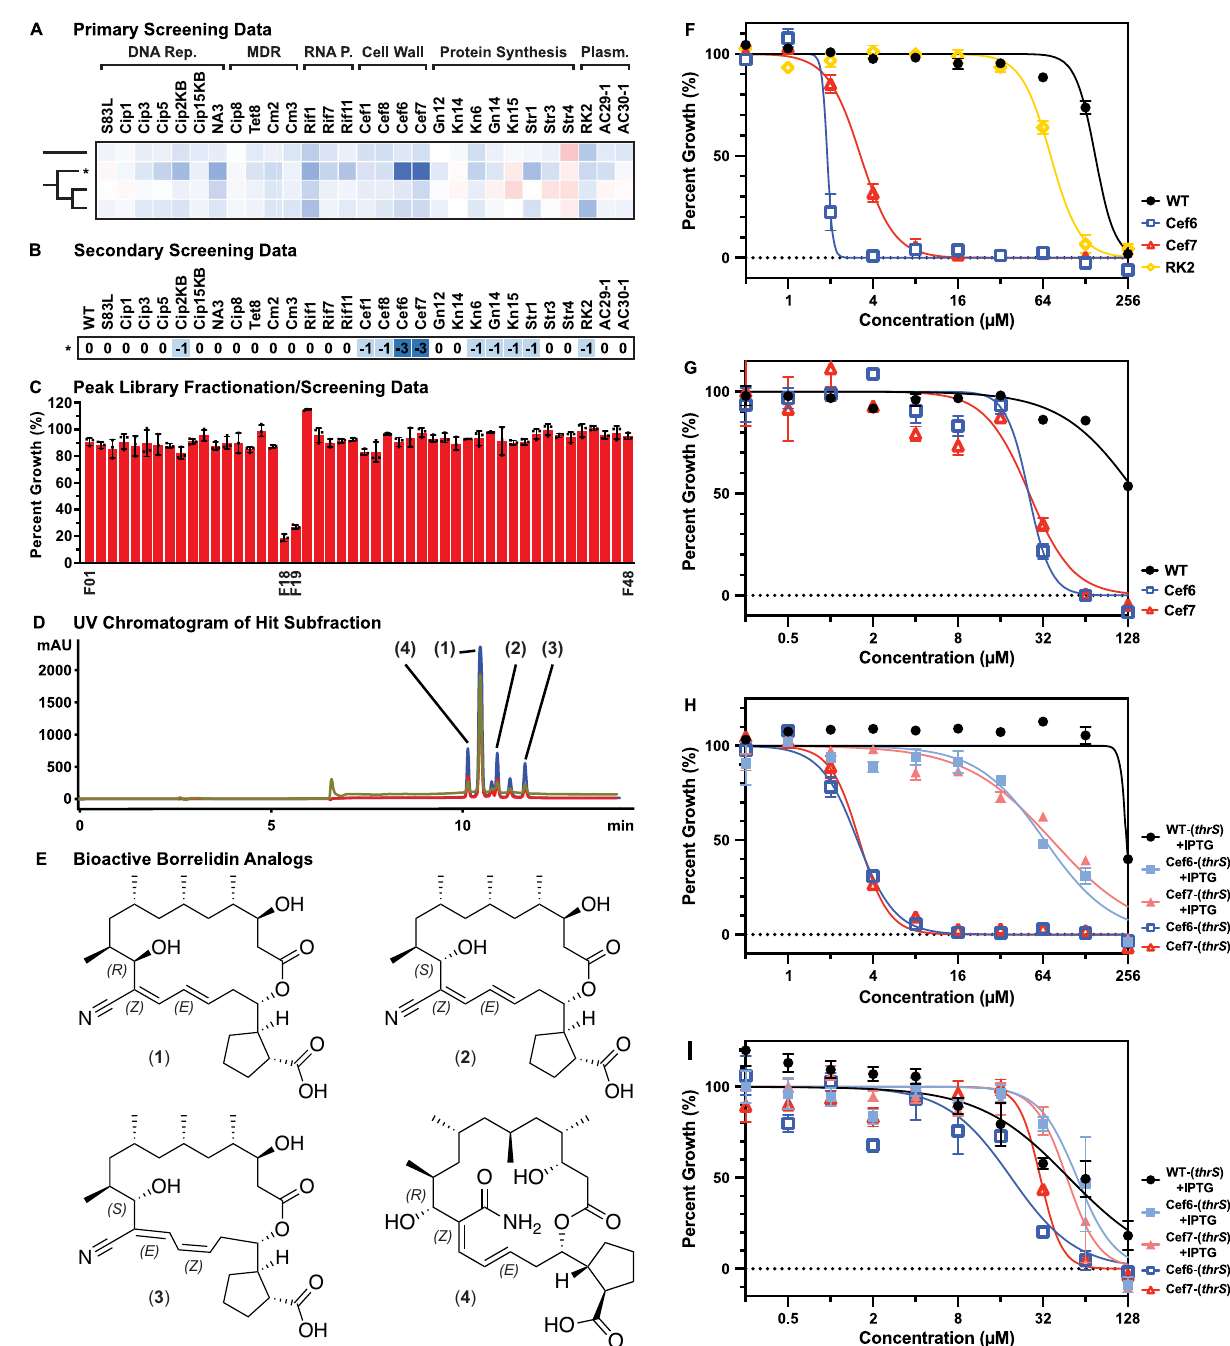
Fig. 4 | Discovery, isolation, and characterization of CS-active borrelidins. A Primary screening data and dendrogram of hit extract RLUS-1732D (*). B Secondary screening data of RLUS-1732D ( * ) as dilution series. Values represent Log 2 (MIC) difference from wildtype; blue = decreasing MIC values (CS). C Peak Library fractionation of hit extract RLUS-1732D and subsequent bioactivity testing pointed to two neighboring subfractionswith strong inhibition againststrainCef7. D HPLC-UV chromatogram of bioactive subfractions F18/19 from RLUS-1732D.Red curve=210nmwavelength;bluecurve=254nm;goldcurve=280nm. E Structures ofborrelidinA( 1 ),F( 2 ),H( 3 ),andnewcompoundborrelidinP( 4 ). F Dose-response